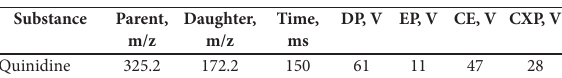
Table 3. Multiple reaction monitoring (MRM) parameters of lisinopril.